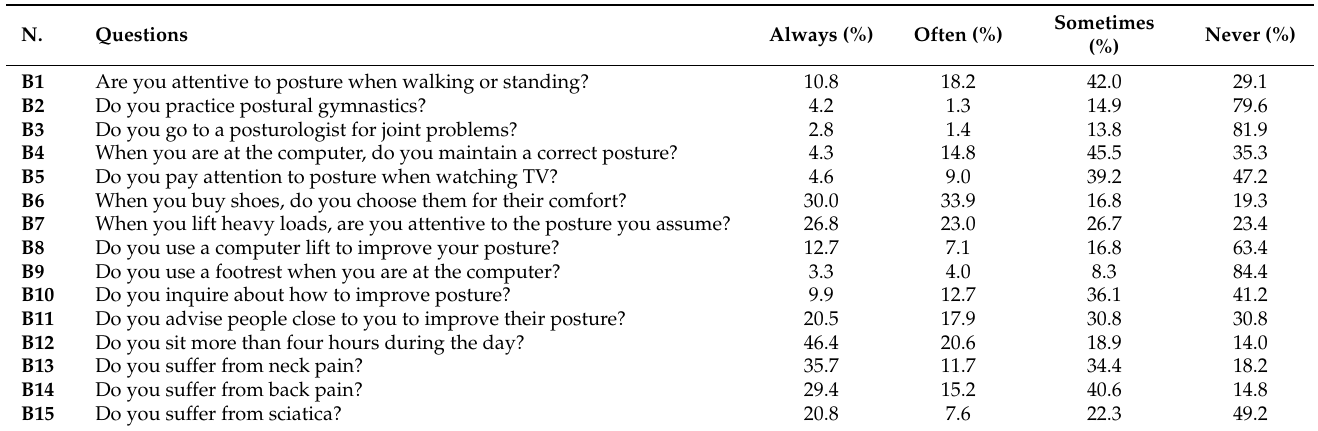
Table 4. Behavior of respondents.